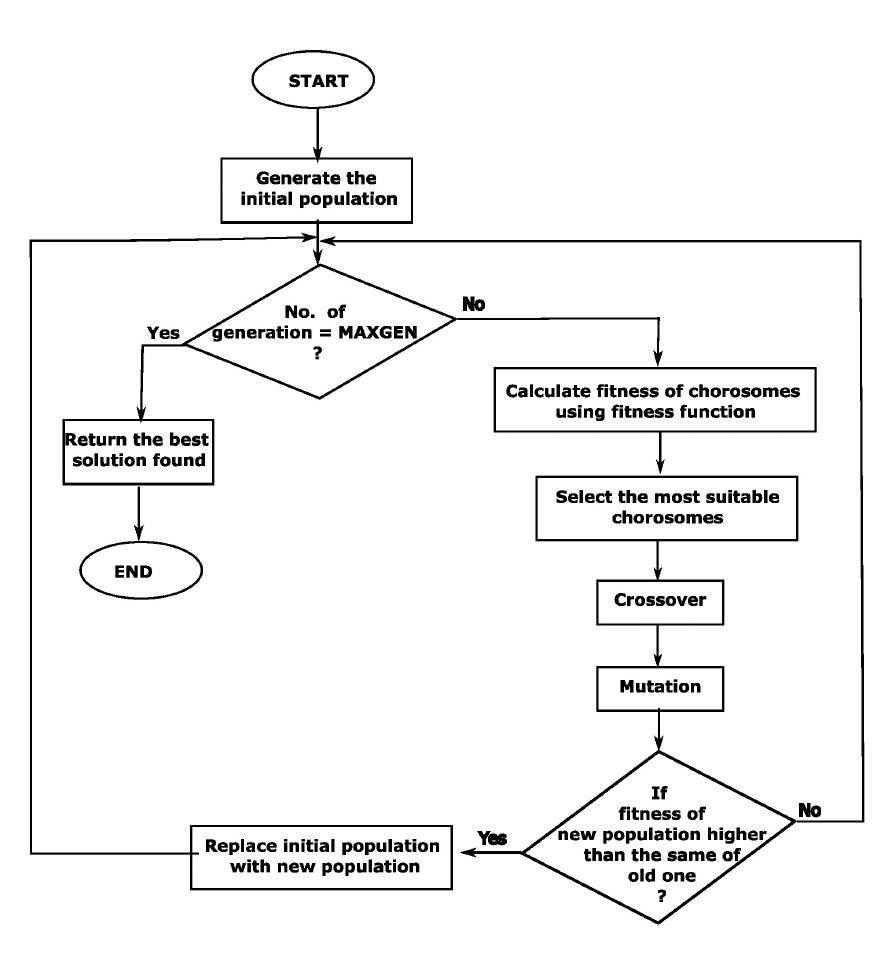
Figure 2. Flowchart of the